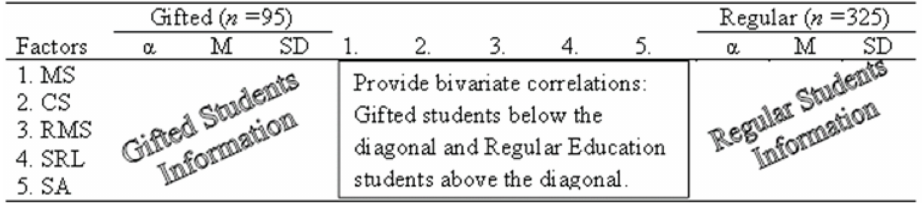
TableA1 | Bivariate correlations, means, SD, and reliability coefficient disaggregated by gifted and regular education